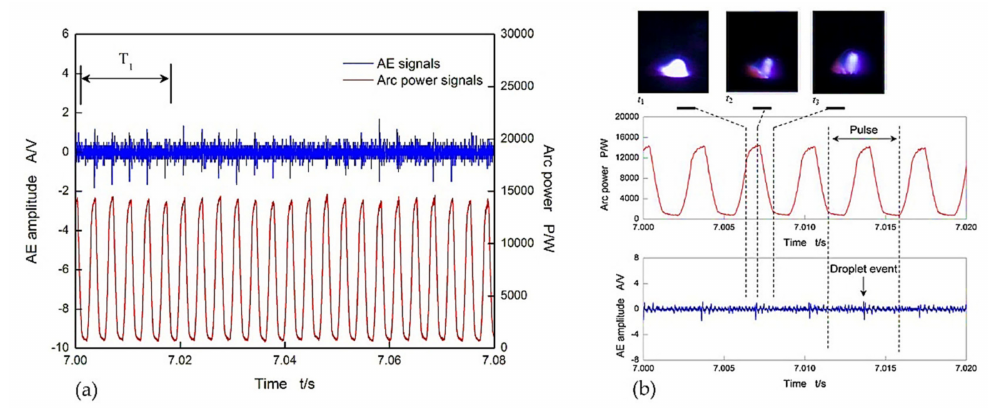
Figure 9. Pulsed arc and Pulsed droplet transfer Mode: ( a ) Arc power signal and corresponding AE signal and ( b ) breakup of time T1. Reprinted with permission from Ref. [22]. Copyright 2018